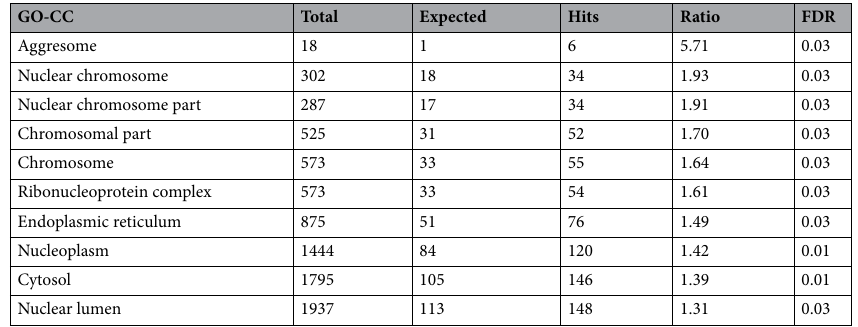
Table 1. Significantly overrepresented GO-CC terms for a list of 2075 Ensembl gene ID positioned in transmission ratio distortion genomic regions associated with strong gametic interaction. GO-CC Gene Ontology-Cellular Component, Total total number of genes in the genome associated with each GO term, Expected expected number of genes within the network dataset associated with each GO term, Hits observed number of genes within the network dataset associated with each GO term, Ratio Ratio of overrepresentation, FDR false discovery rate.